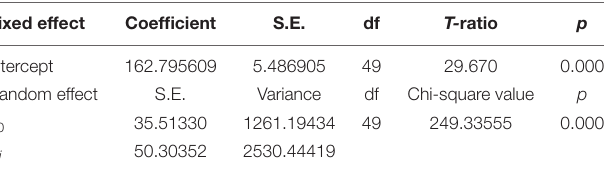
TABLE 2 | Zero model regression results.